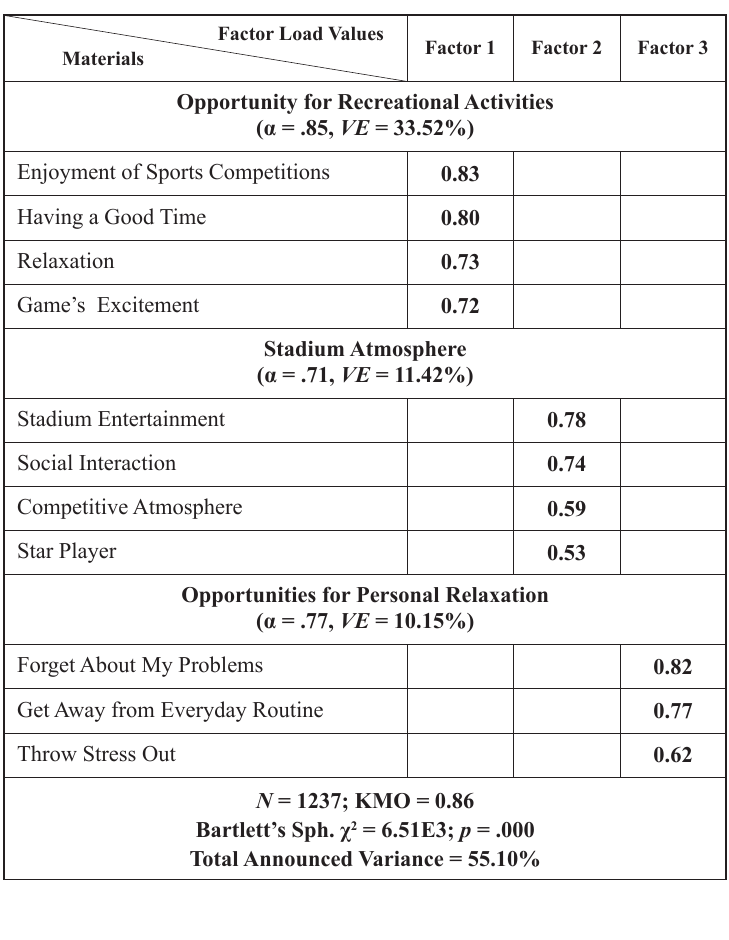
Table 6. Reasons of Super League Football Team Fan Non-Attendance in the Stadium Scale factor analysis load